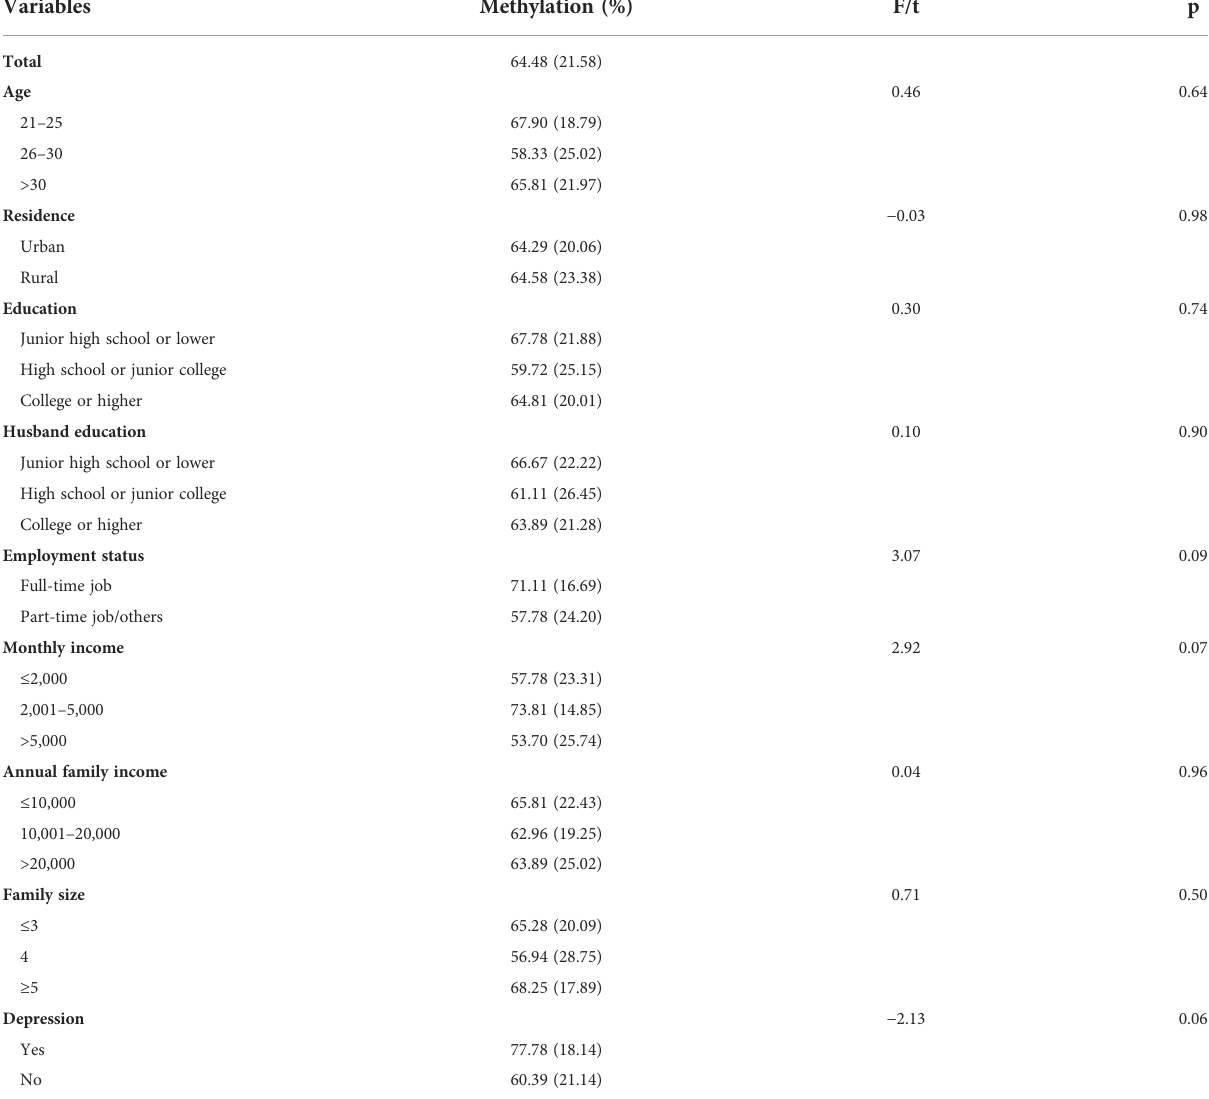
TABLE 2 Levels of NR3C1 methylation among pregnant women, overall and by demographic groups, and levels of